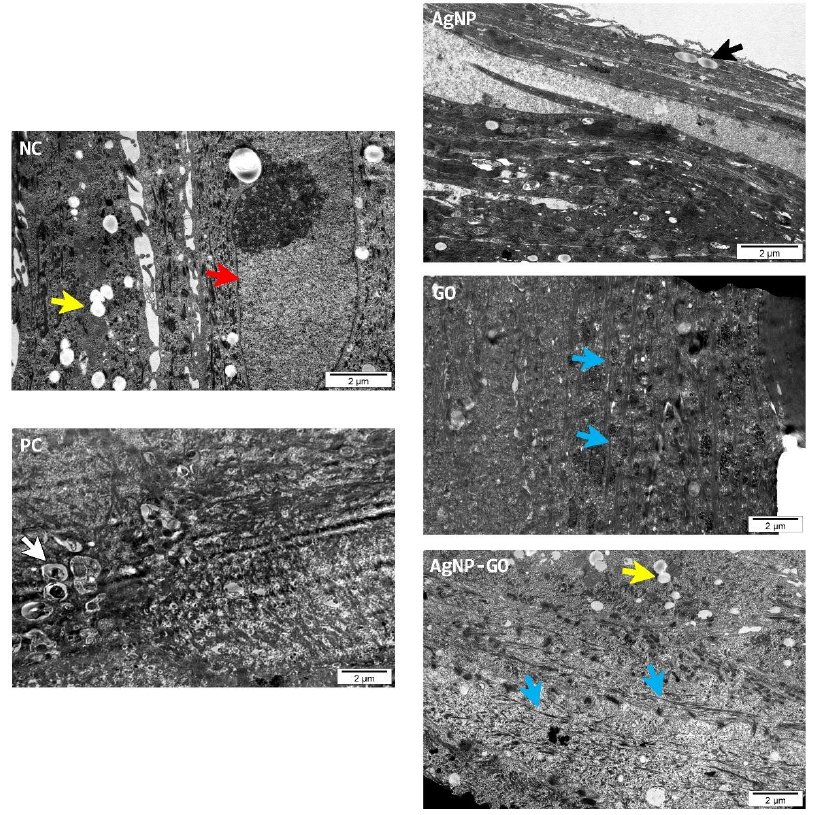
Figure 6. The EpiDerm™ ultrastructure evaluated with a transmission electron microscope (scalebar 2 µm). The arrows indicate the following: red — cells from the granular layer; yellow — lipid droplets; white — places of necrosis; black — nuclei in the stratum corneum; blue — bundle of keratin filaments.